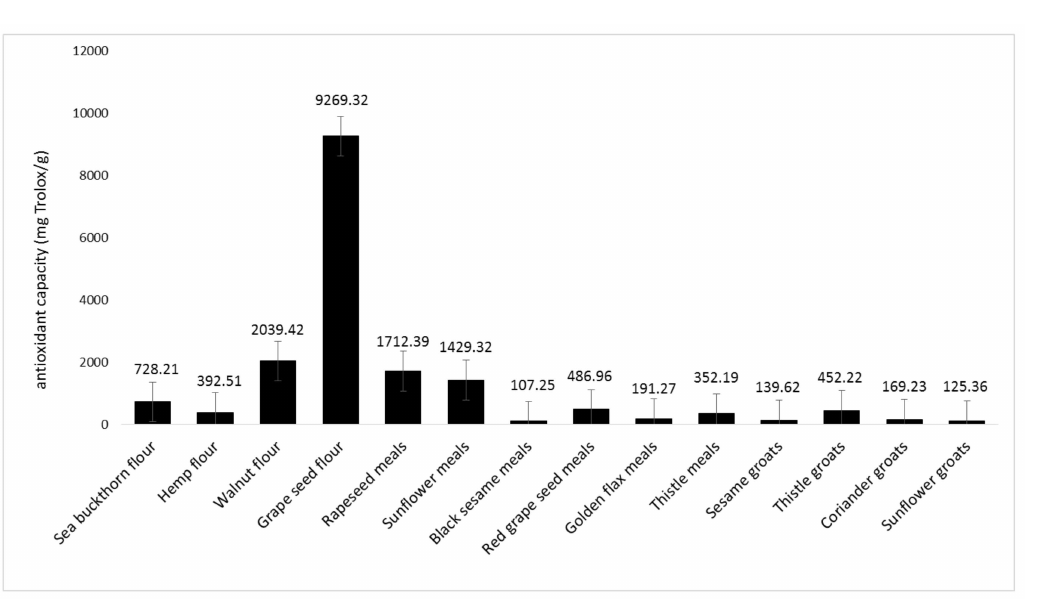
Figure 10. Antioxidant capacity using the PHOTOCHEM device in an ACL system.